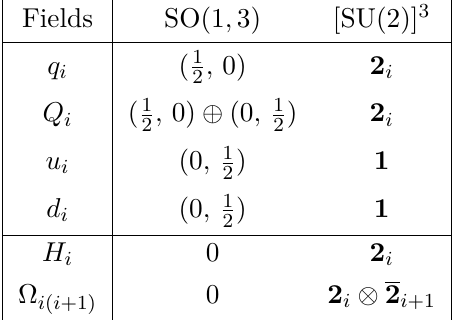
Table 2 . Matter field content of the full